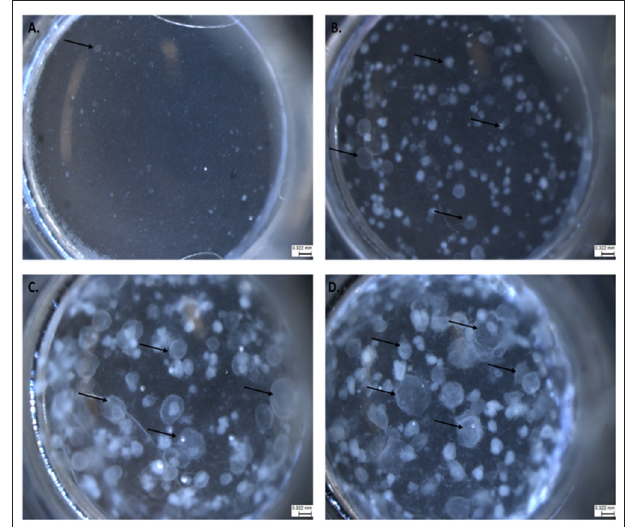
FIGURE 1 | The progression of lung organoid development. Each black arrow indicates an organoid. (A) Initial plating of primary lung epithelial cells (EpCAM) and primary lung fibroblast cells (CD140a) as viewed under light microscopy. (B) The development of lung organoids within 0.5–1.5 weeks. (C) The development of lung organoids between 1.5 and 2 weeks. (D) The development of lung organoids between 2 and 5 weeks of growth. All scale bars are